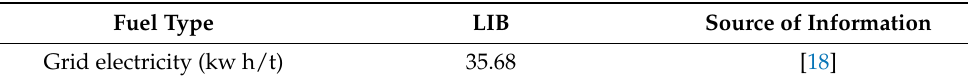
Table 4. The energy consumption of the cascade utilization